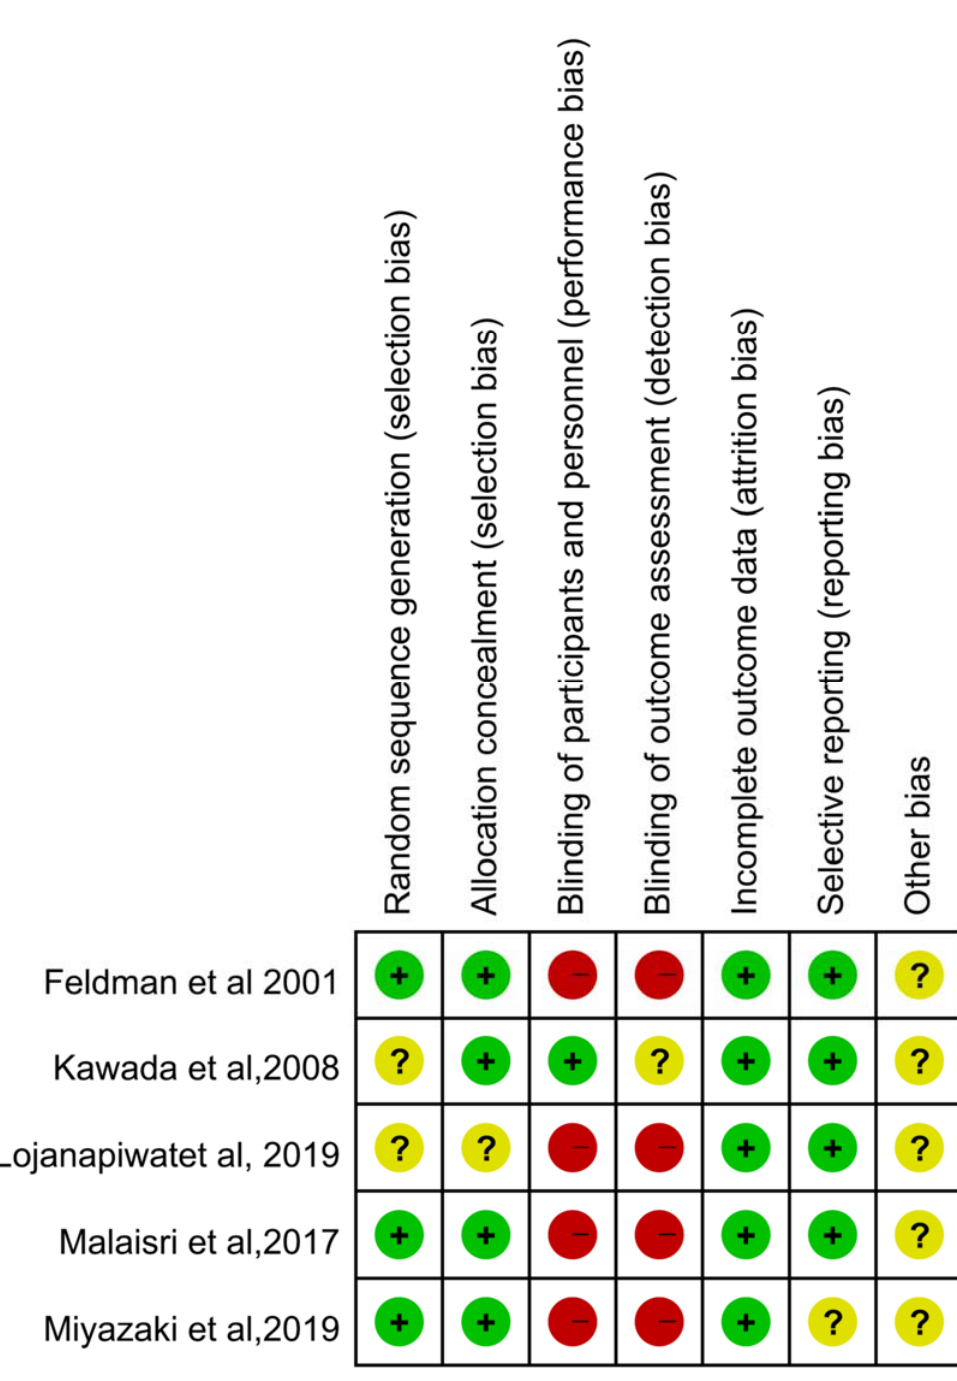
Figure 2. The summary of risk of bias.